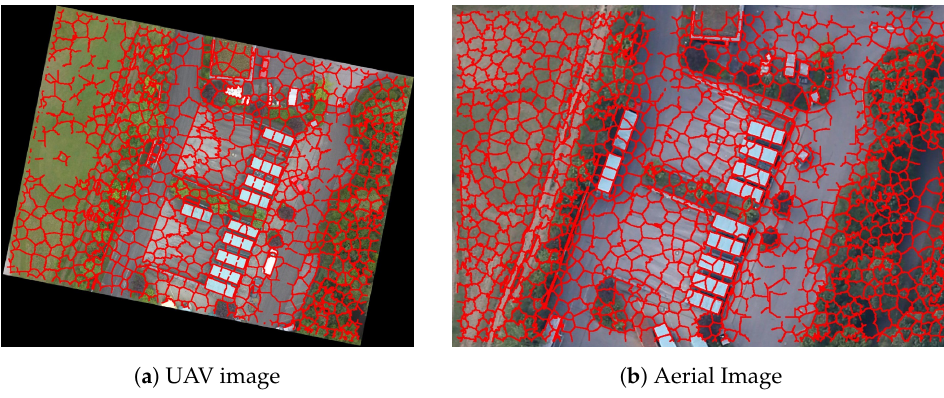
Figure 5. Feature points highlighted in red, namely all of the pixels at the boundaries of superpixels, after removing those feature points located at homogeneous areas for ( a ) the pre-aligned UAV image and ( b ) the aerial image of the Container dataset with 1000 simple linear iterative clustering (SLIC) superpixels.